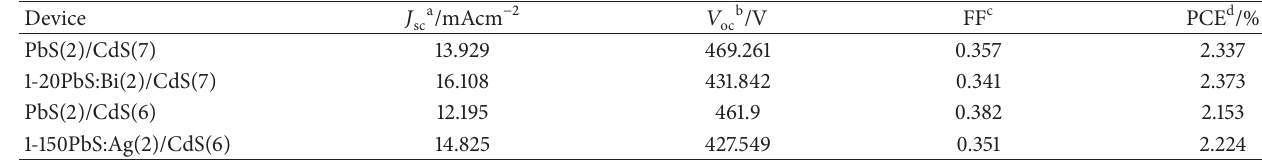
Figure 5: (a) Diffuse reflection absorption spectra, (b) the plot calculated by using 𝛼ℎ ] = 𝐴(ℎ ] −𝐸 𝑔 ) 2 equation from absorption spectra, and (c) UPS spectra of PbS, Bi-doped-PbS, and Ag-doped-PbS QDs. Table 4: Photovoltaic performances extracted from current-voltage measurements of different working electrodes.